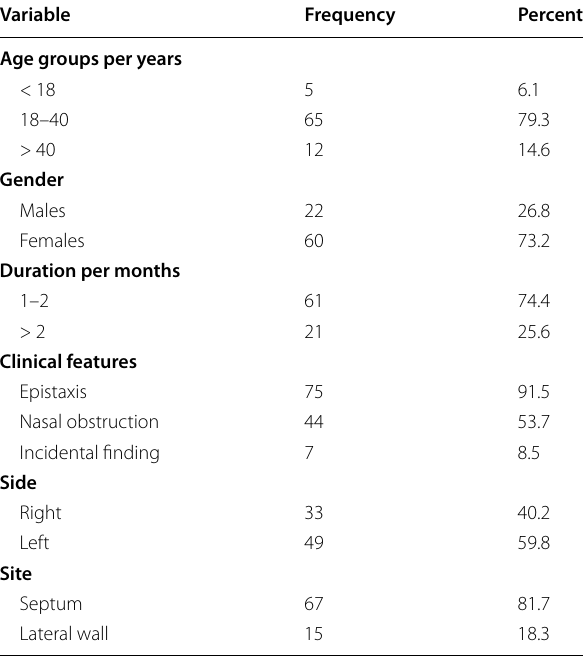
Table 1 Demographic and clinical characteristics of 82